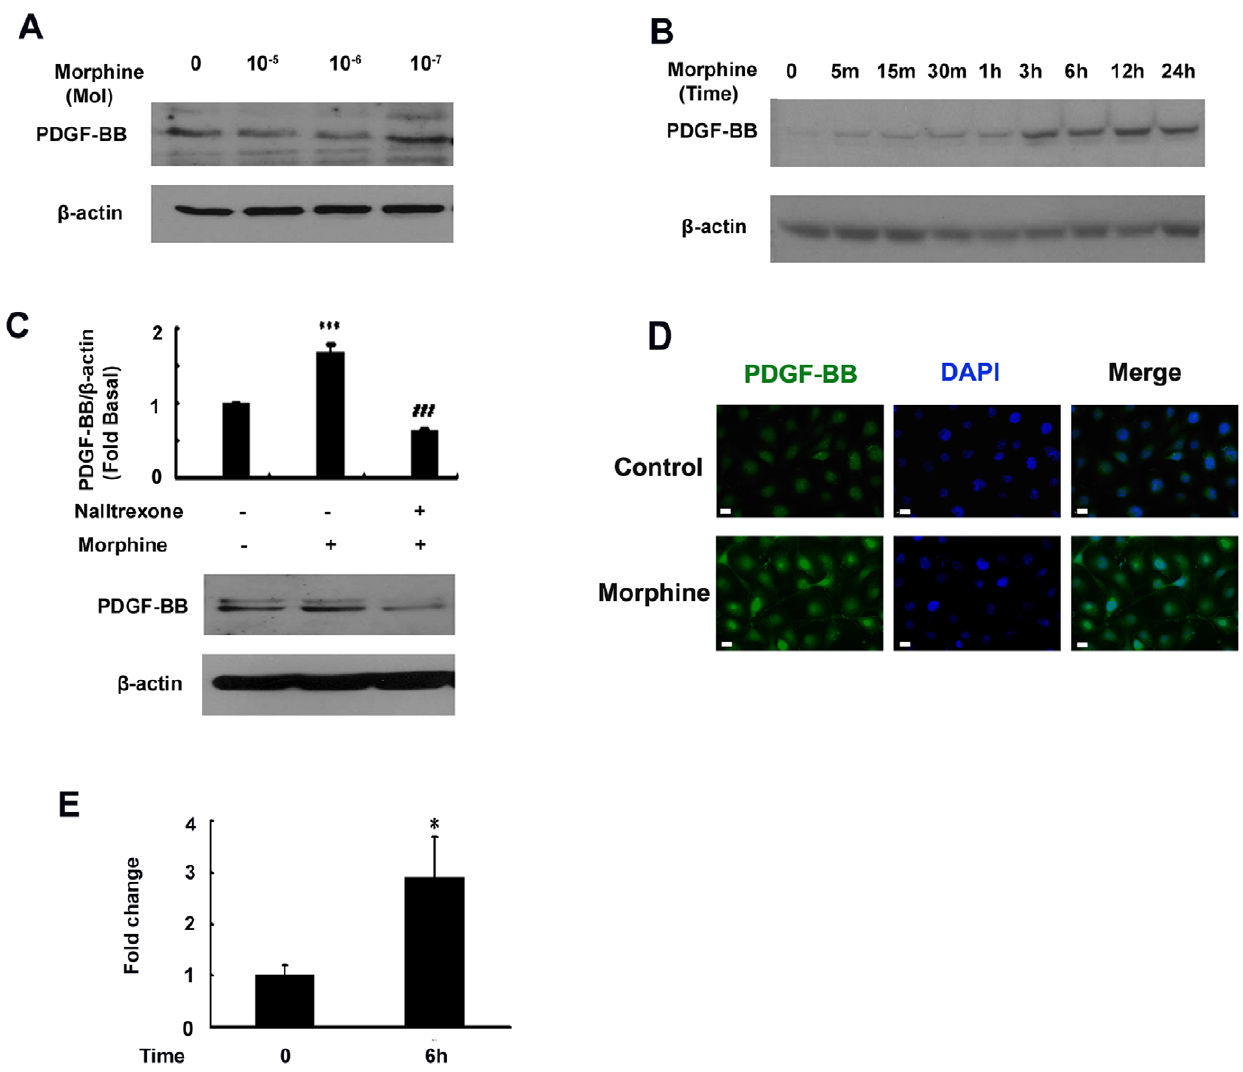
Figure 1. Morphine-mediated induction of PDGF-B chain expression in human brain microvascular endothelial cells. ( A ) Dose- dependent induction of PDGF-BB protein by morphine (10 2 5 , 10 2 6 and 10 2 7 M) in human brain microvascular endothelial cells (HBMECs). ( B ) Time- dependent induction of PDGF-BB protein by morphine (10 2 7 M) in HBMECs. ( C ) Opioid receptor antagonist naltrexone (1 m M) abrogates morphine- mediated induction of PDGF-BB. ( D ) Representative picture of PDGF-B chain staining in HBMECs treated with morphine for 12 hrs. Scale bar=5 m m. ( E ) Induction of PDGF-B mRNA in HBMECs exposed to morphine after 6 hrs. All the data are presented as mean 6 SD of three individual experiments. *p , 0.05, ***p , 0.001 vs control group; ### p , 0.001 vs morphine